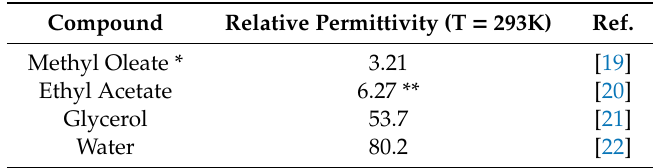
Table 2. Relative Permittivity of relevant substances in the ethyl acetate–water–crude glycerol mixture.